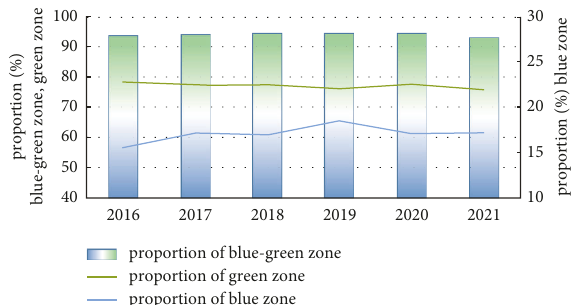
Figure 5: BGS changes of Baiyangdian Wetland from 2016 to Table 2: Transfer matrix of BGS in Baiyangdian Wetland from 2016 to 2021 (km 2 ). Green space Blue space Urban and rural construction space 2016 Green space 267.61 294.90